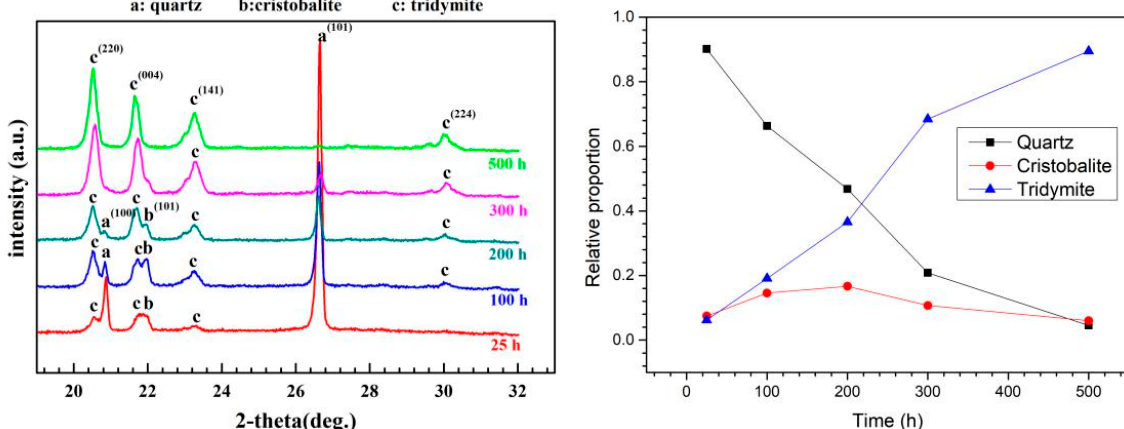
Figure 11. Phase evolution of fine quartz—potassium silicate glass composites after holding at 900 °C for different time.